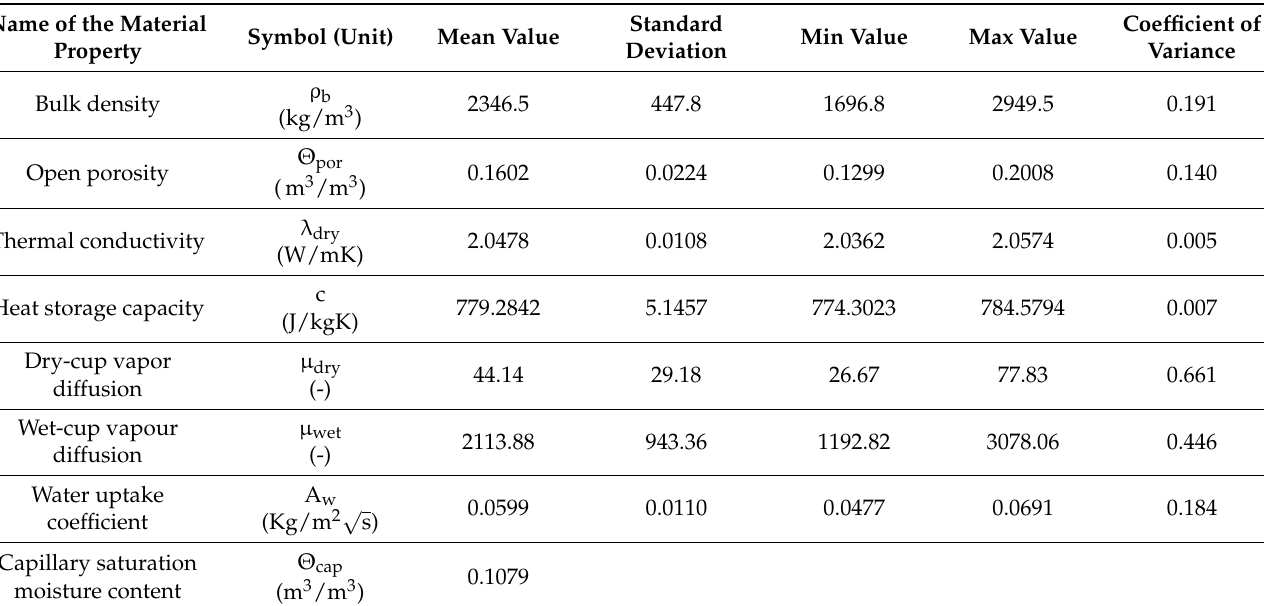
Table 7. Determined properties of the dolomite and corresponding test methods.